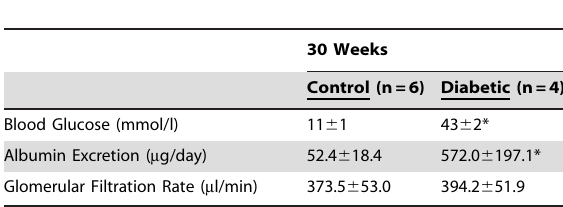
Table 2. Kidney phenotype at 30 weeks of